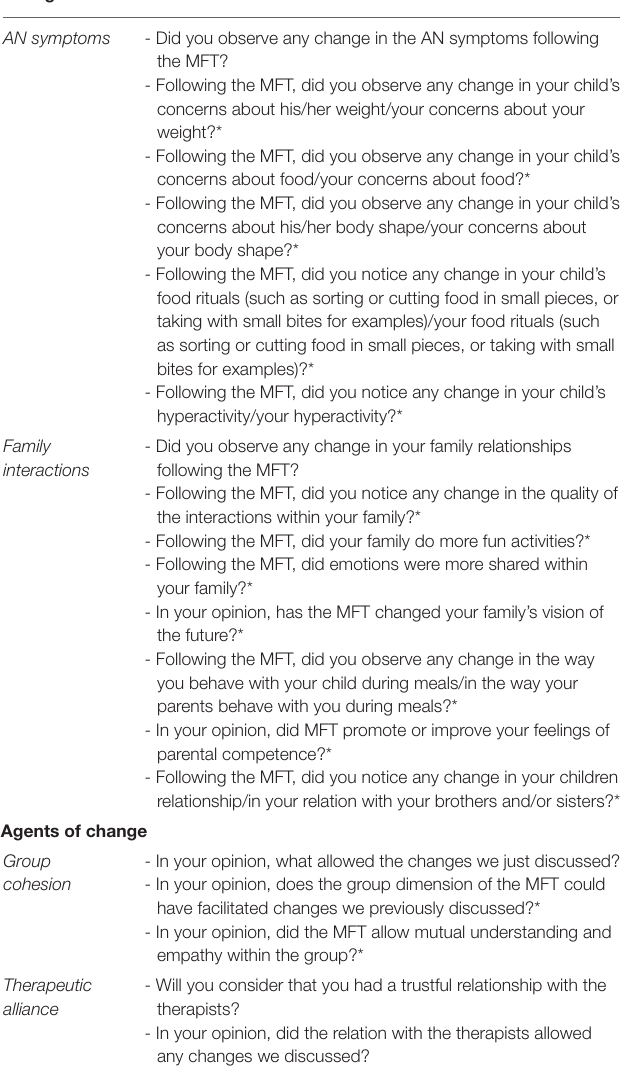
TABLE 2 | Demographic and clinical characteristics of the adolescents included in the